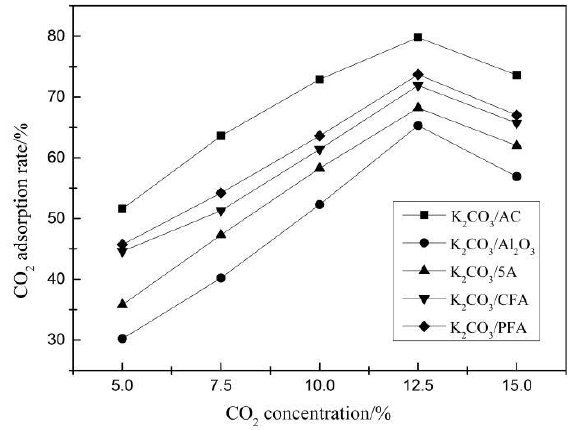
Figure 3. CO 2 adsorption rate at different CO 2 concentrations.